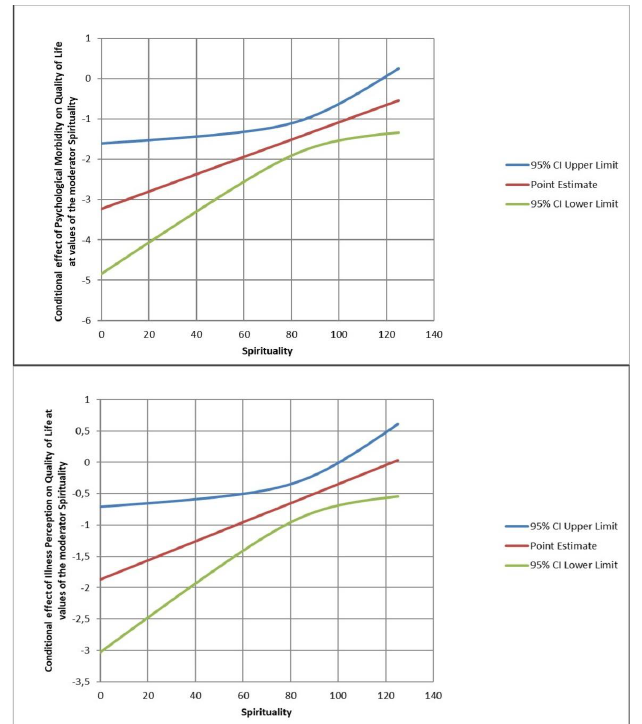
Figure 3. The moderating effect of spirituality (reflection and positive interpretation of disease and spiritual support) in the relationship between psychological morbidity and QoL and between illness perception and quality of life.